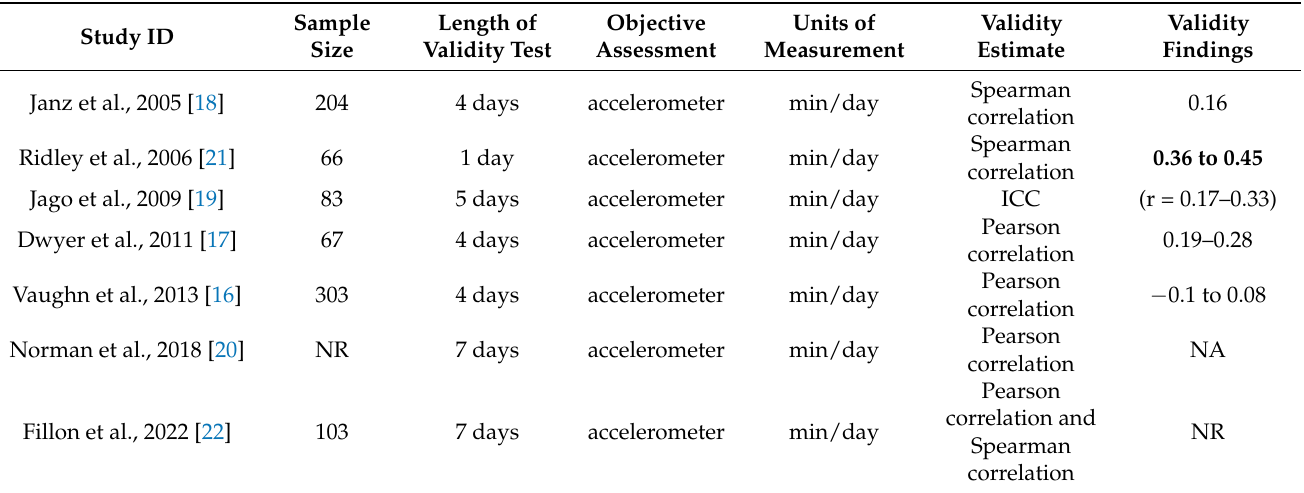
Table 3. Descriptive characteristics of the validity estimates and psychometric properties of the